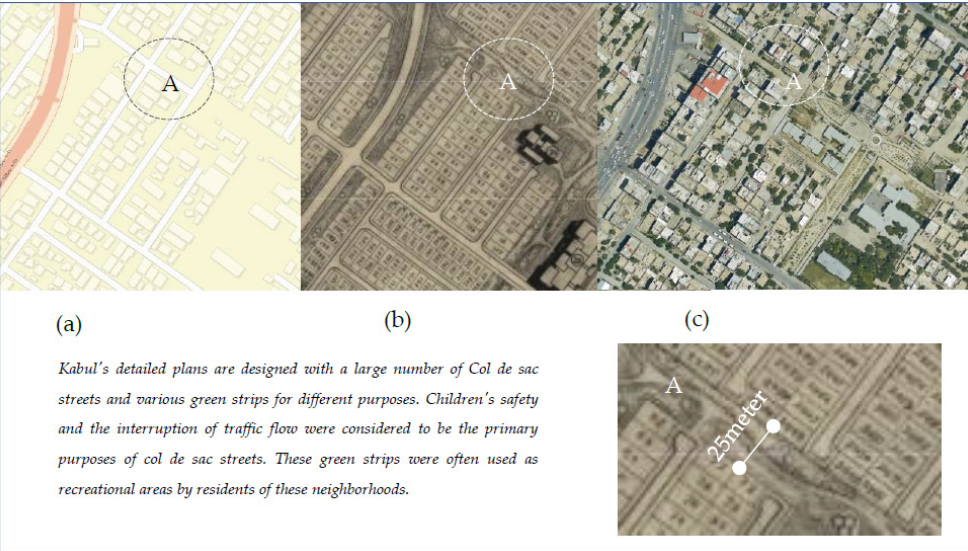
Figure 11. Structure layout differences; ( a ) focused map road; ( b ) detailed plans designed in late 1970s; ( c ) aerial photograph.